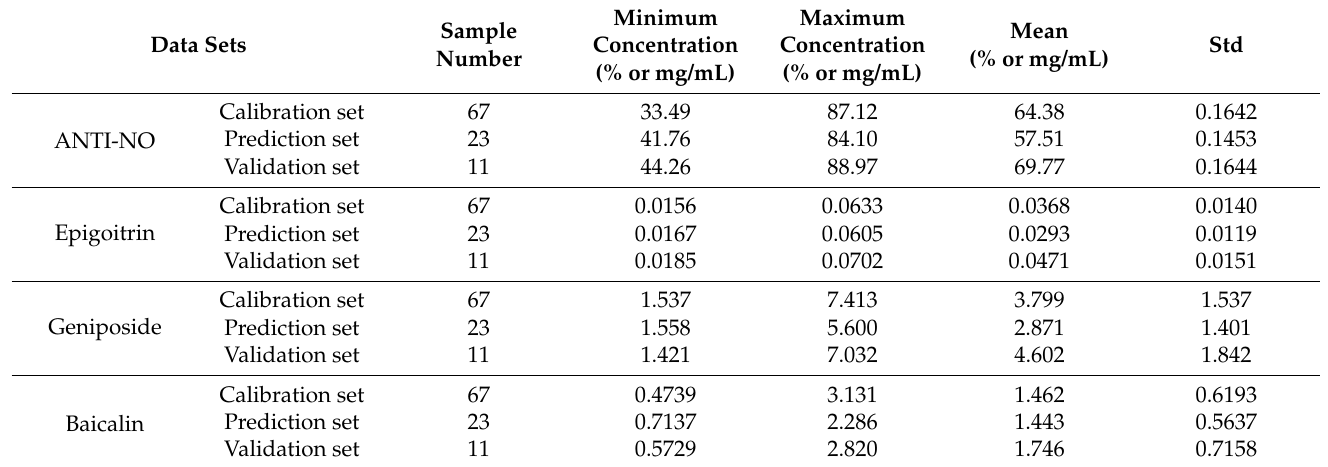
Table 3. Reference values for 4 indexes in the data